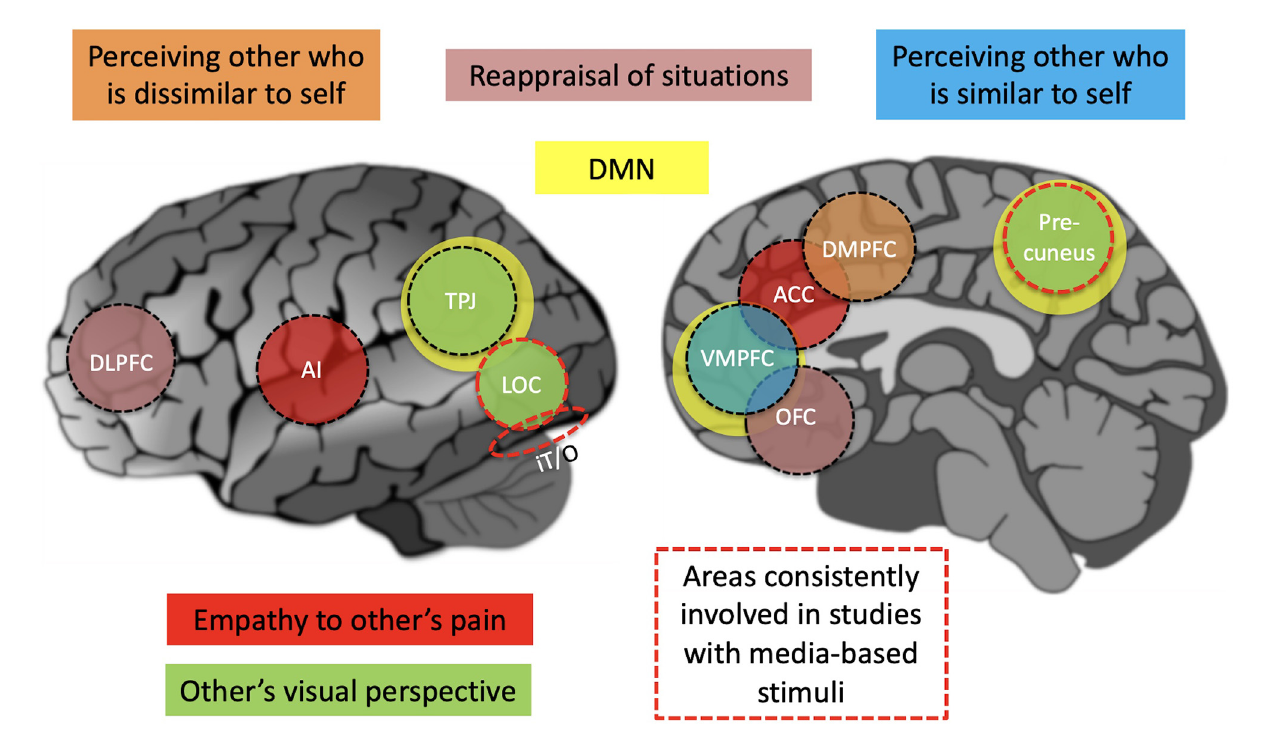
FIGURE1 A simplified summary schematic of brain regions that are involved in perspective-taking tasks. Areas consistently involved in studies with media-based stimuli include the precuneous, LOC, and IT/O, with the precuneus also being an important part of the DMN that is plotted with yellow color. Areas involved with specific perspectives, such as empathy to other’s pain, are plotted with different colors. ACC, anterior cingulate cortex; AI, anterior insula; DLPFC, dorsolateral prefrontal cortex; DMN, default mode network; DMPFC, dorsomedial prefrontal cortex; IT/O, inferior temporal/occipital cortex; LOC, lateral occipital cortex; OFC, orbitofrontal cortex; TPJ, temporoparietal